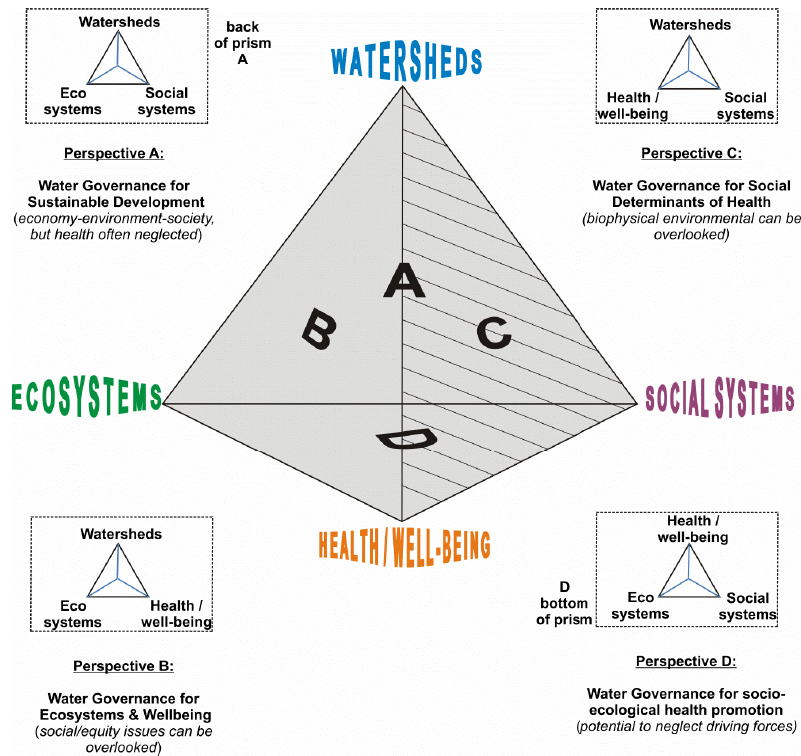
Figure 1. The Watershed Governance Prism. Source: Parkes et al. [11].